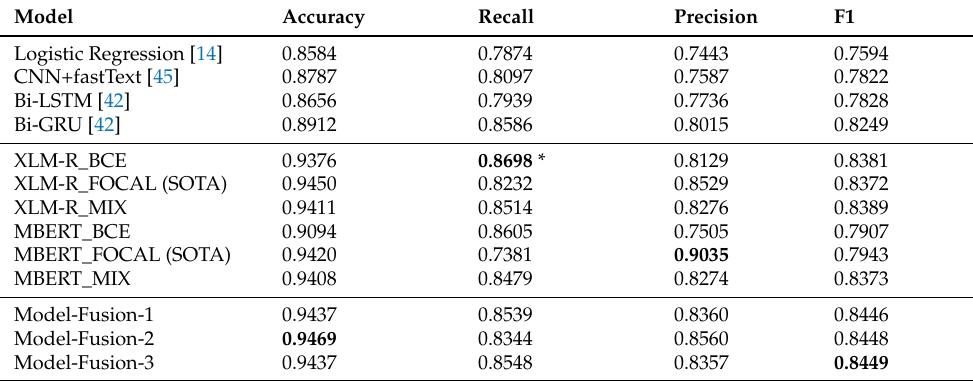
Table 4. Performance evaluation on the test